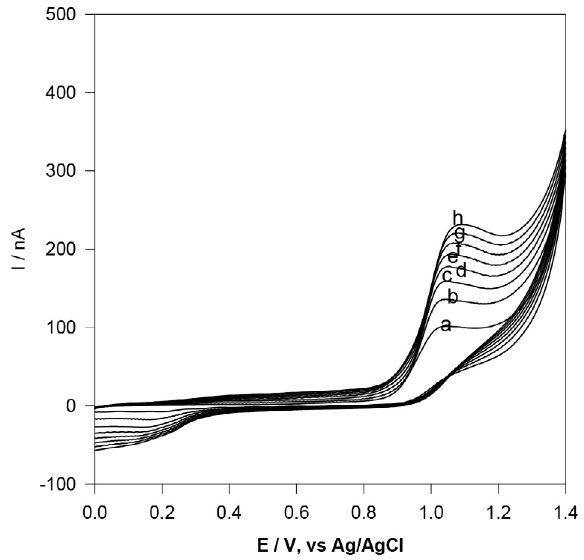
Figure 2. Cyclic voltammograms for 3.85 × 10 –5 mol/L solution of chlorzoxazone in 0.04 mol/L Britton-Robinson buffer pH 6.5, on carbon paste electrode with different scan rates; a, 10; b, 20; c, 30; d, 40; e, 50; f, 60; g, 70; and h, 80